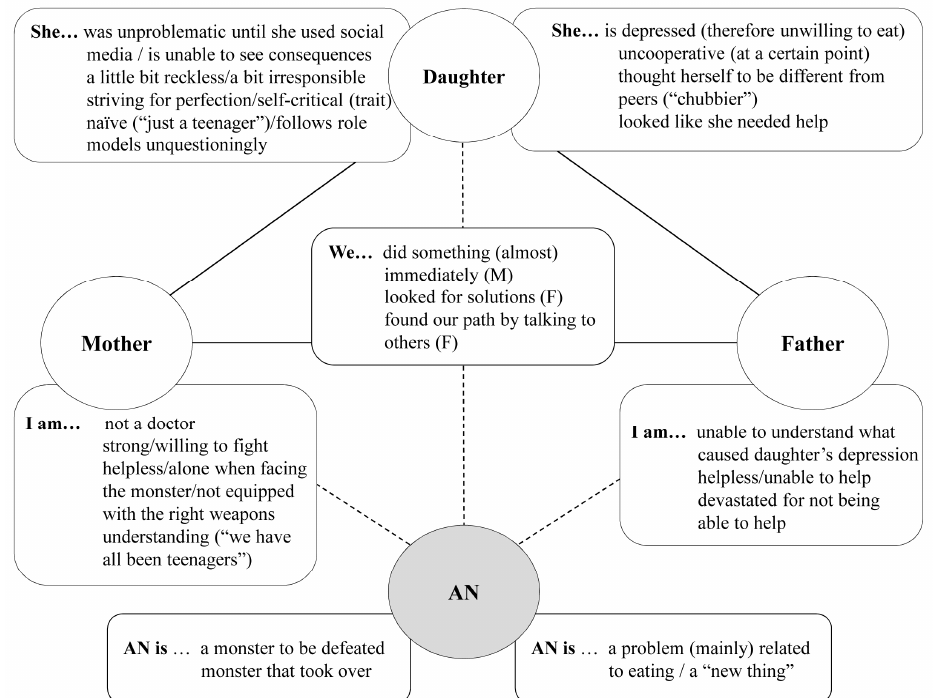
Figure 2. Second parental dyad: overview of positions claimed for oneself (mother/father/dyad) and assigned to the daughter, and anorexia nervosa (AN) (M = mother; F = father). The father lacked agency throughout when talking about his own family system.